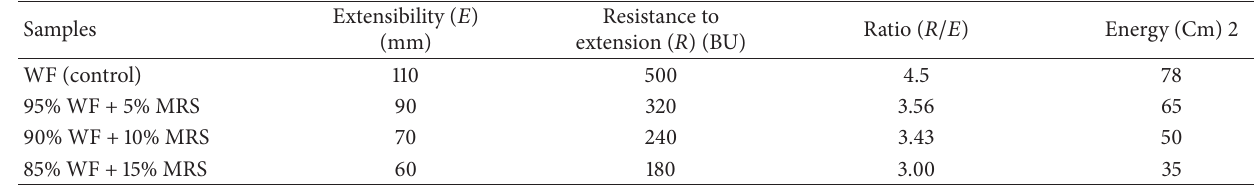
Table 5: Extensograph parameters of dough prepared from different formulas.